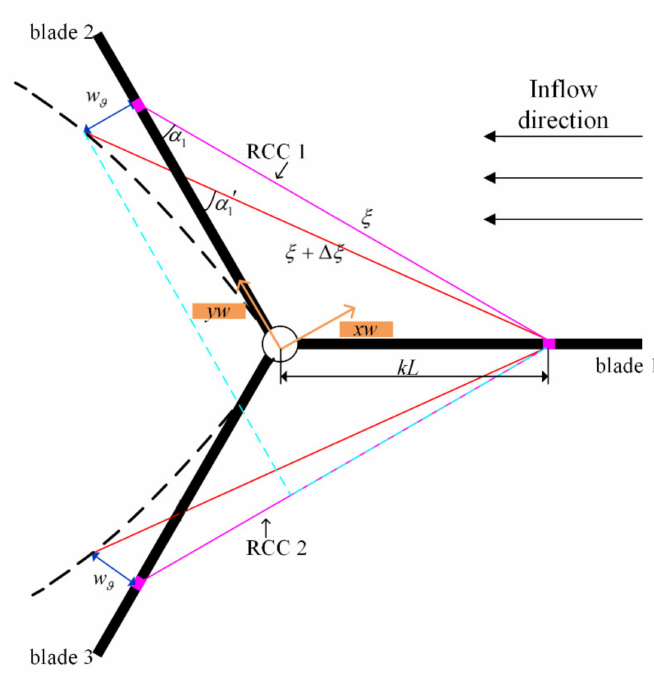
Figure 6. Geometric relationship of the reinforcing cable and